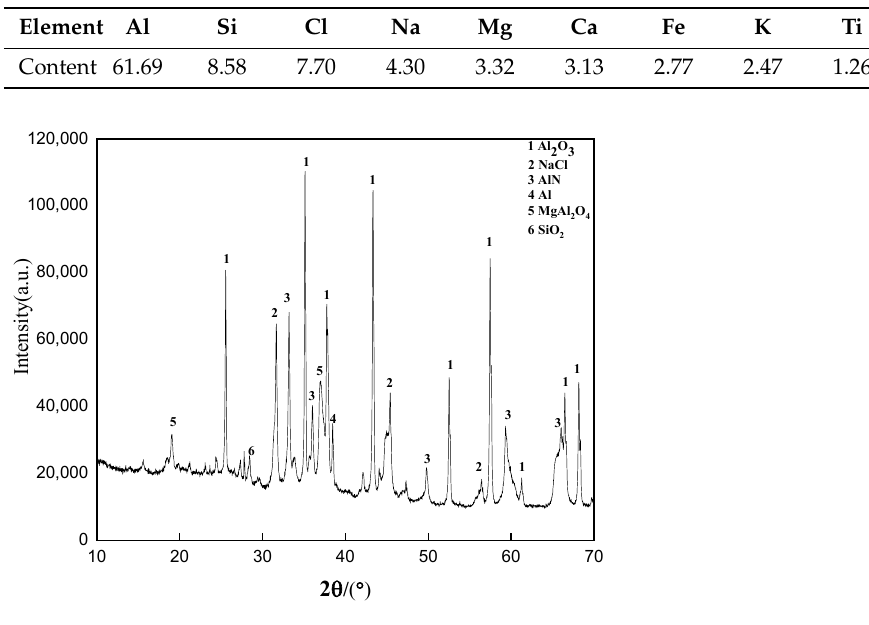
Figure 2. XRD pattern of original aluminum dross.